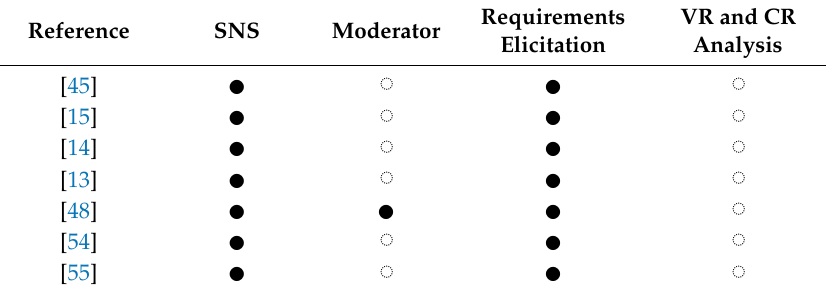
Table 13. Summary of related work that considers aspects related to our research.